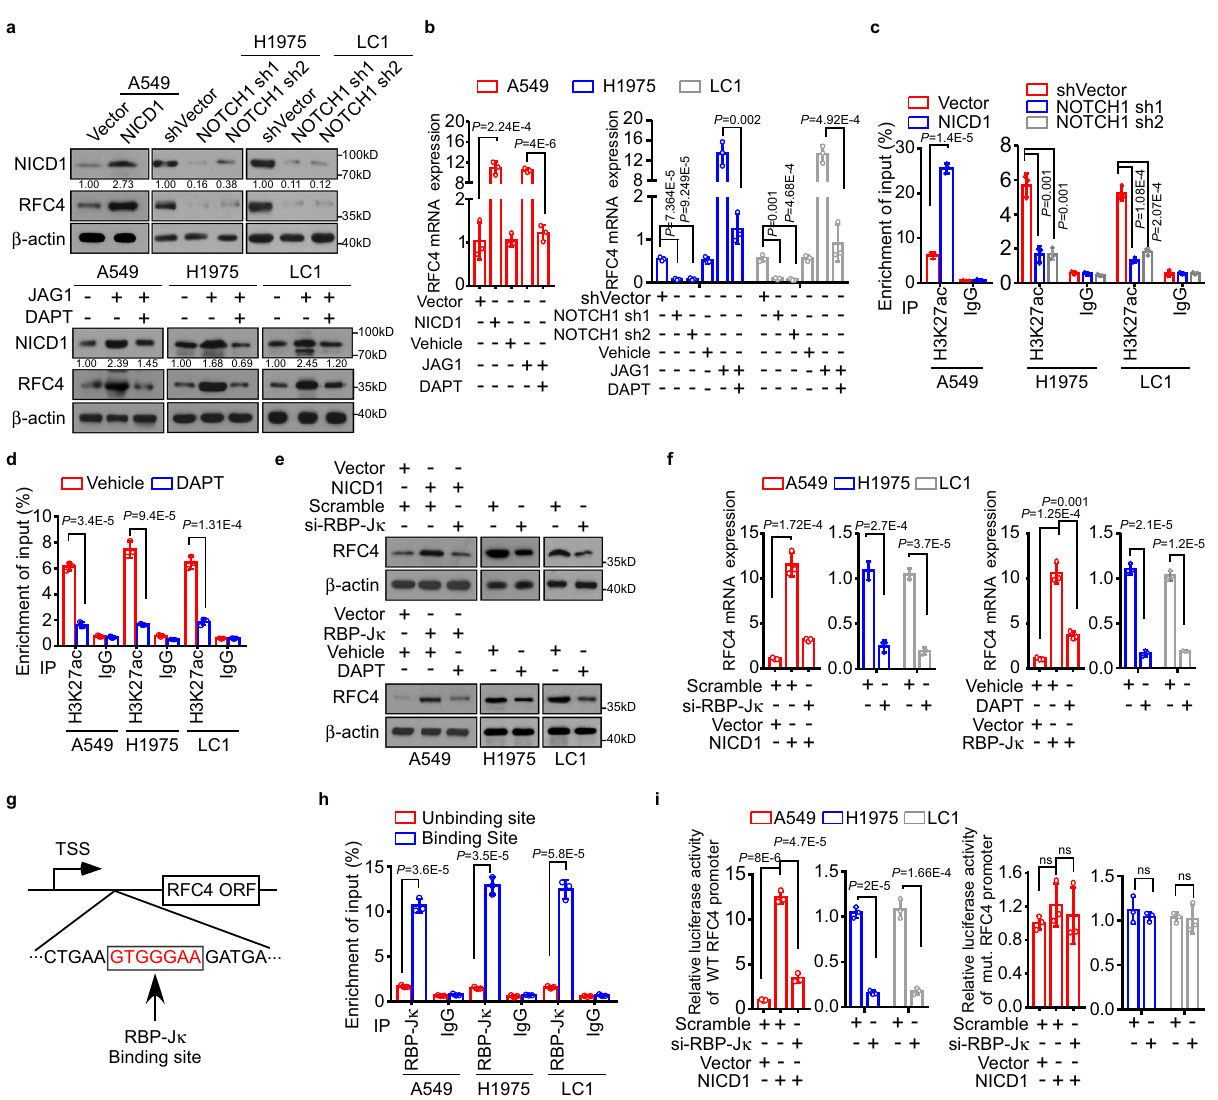
Fig. 2 RFC4 is a de novo direct transcriptional target of Notch1 signaling. a , b Effect of activating Notch signaling by overexpression of NICD1, JAG1, or inhibiting Notch signaling by treatment of a γ -secretase inhibitor DAPT on both protein and mRNA levels of RFC4 in A549, H1975, and LC1 cells. Representative images of three independent reproducible experiments are shown. c , d ChIP analysis following H3K27ac immunoprecipitation shows the interaction between H3K27ac and the promoter region of the RFC4 gene in response to overexpression of NICD1 or treatment of DAPT. IgG immunoprecipitation was used as a negative control. e The effect of silencing RBP-J κ or overexpressing RBP-J κ together with treatment of DAPT on protein levels of RFC4 in A549, H1975, and LC1 cells. Representative images of three independent reproducible experiments are shown. f The effect of silencing RBP-J κ and overexpressing RBP-J κ together with treatment of DAPT on mRNA levels of RFC4 in A549, H1975, and LC1 cells. g Schematic diagram of potential binding site for RBP-J κ in the promoter region of RFC4. h ChIP enrichment assay shows binding of RBP-J κ to the predicted binding site in the promoter region of RFC4 in stimulation of JAG1. IgG immunoprecipitation was used as a negative control. i The effects of overexpressing NICD1 together with RBP-J κ depletion on luciferase activities of the reporter constructs spanning wild type or mutant predicted putative binding site for RBP-J κ in the promoter region of RFC4. Data in panels b – d , f , h and i are presented as mean ± SD derived from three independent experiments. Two-way ANOVA multiple comparison analysis was used for statistical analysis. Source data are provided as a Source Data fi